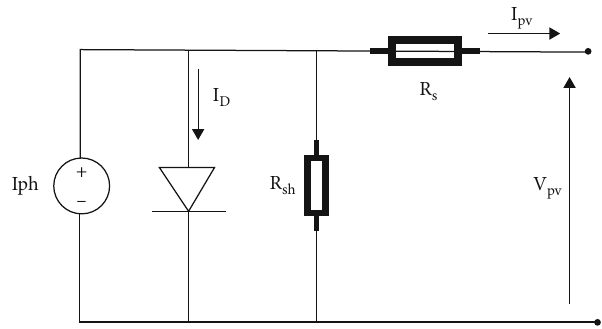
Figure 2: PV cell single diode